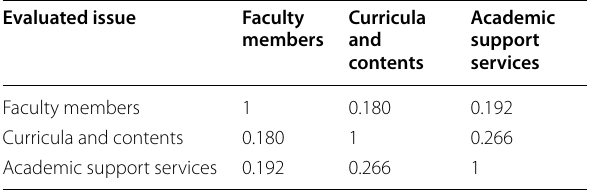
Table 6 Correlation matrix (Pearson) for the three evaluated